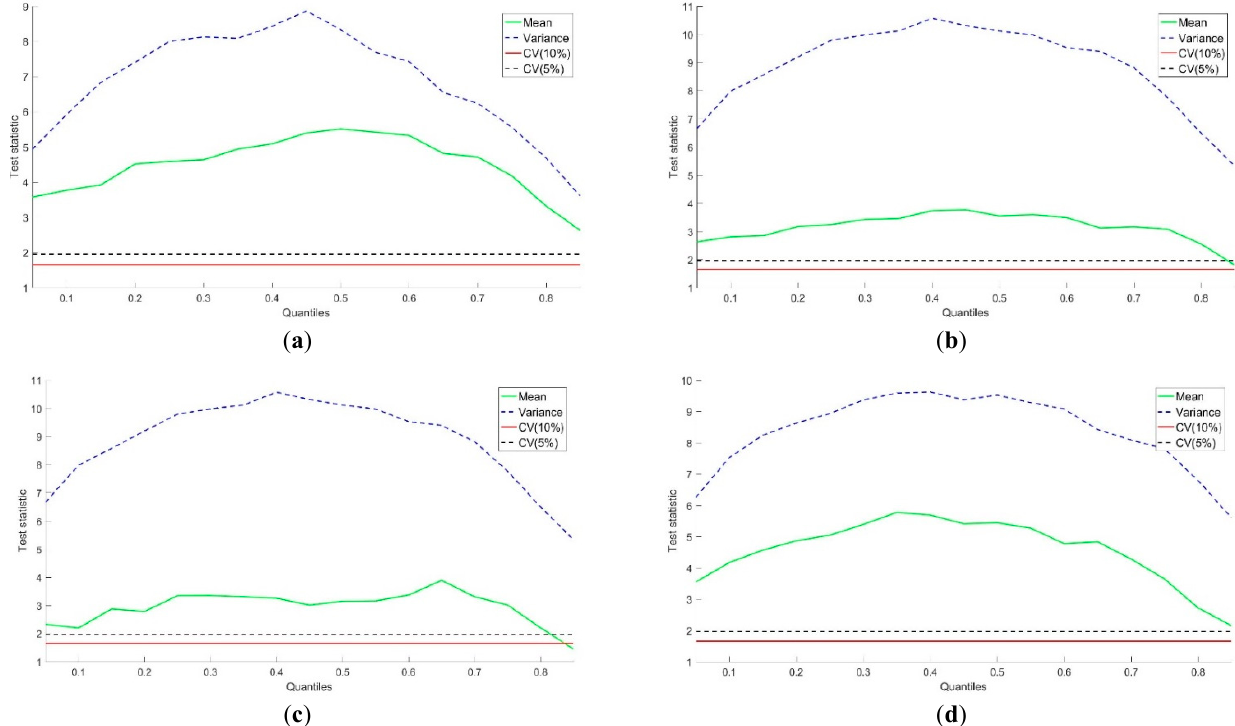
Figure 5. Non-parametric causality-in-mean, in-variance and the 5% and 10% critical values (CV) from USD returns to the stock market returns at various quantiles, respectively: ( a ) USD-US; ( b ) USD-CHINA; ( c ) USD-UK; ( d ) USD-JAPAN.